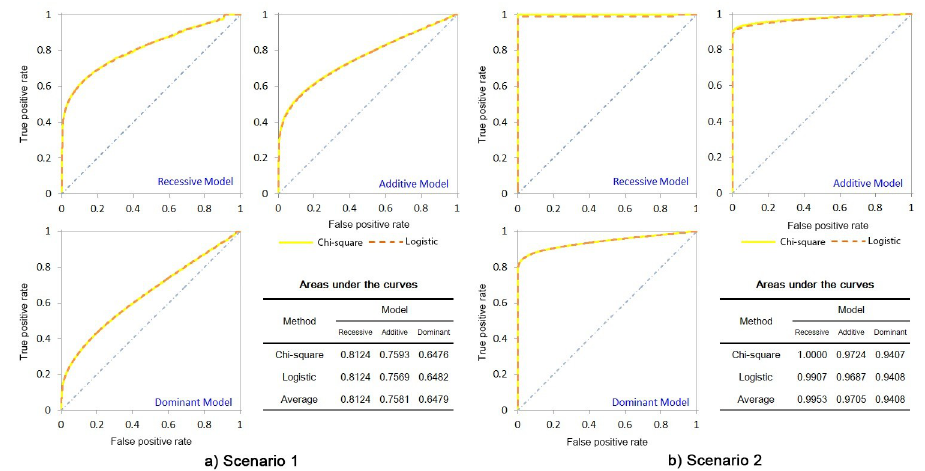
Fig 1. Receiver operating characteristic curves and areas under the curves on simulation datasets. Four significant figures are given here in order to display the area differences among the approaches.